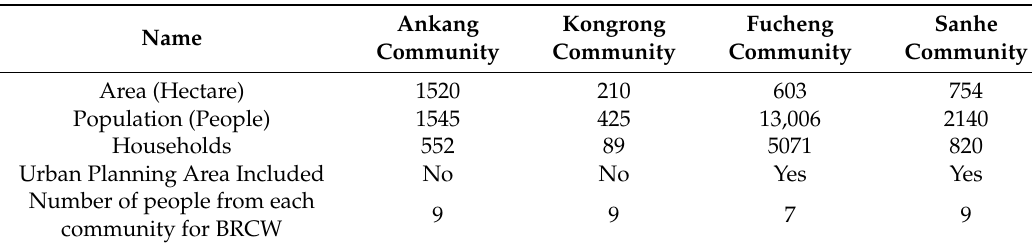
Table 1. Basic contexts and BRCW members condition of